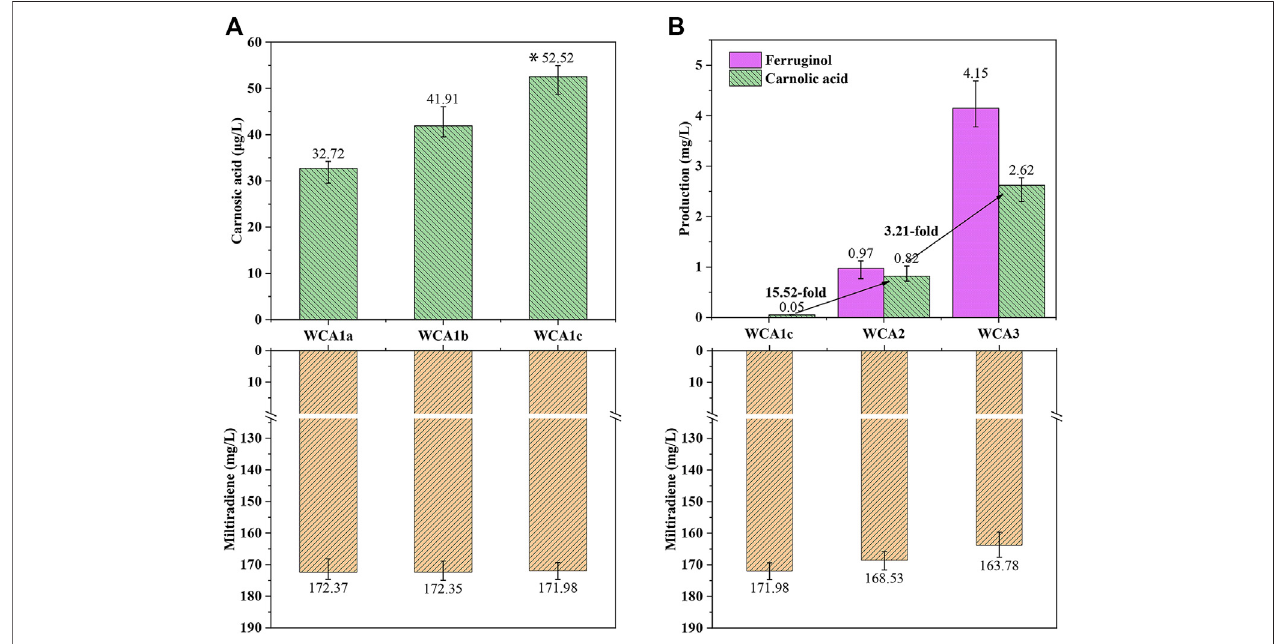
FIGURE 4 | CA production in S. cerevisiae increased in a stepwise manner. (A) Production of CA and miltiradiene by strains WCA1a – c. *: The CA titer of strain WCA1cissigni fi cantlyhigherthanthatofWCA1b.* p < 0.05;** p < 0.01;*** p < 0.001 (B) Productionofmiltiradiene,ferruginolandCAbystrainWCA2-3.Thedataarethe averages of three separate